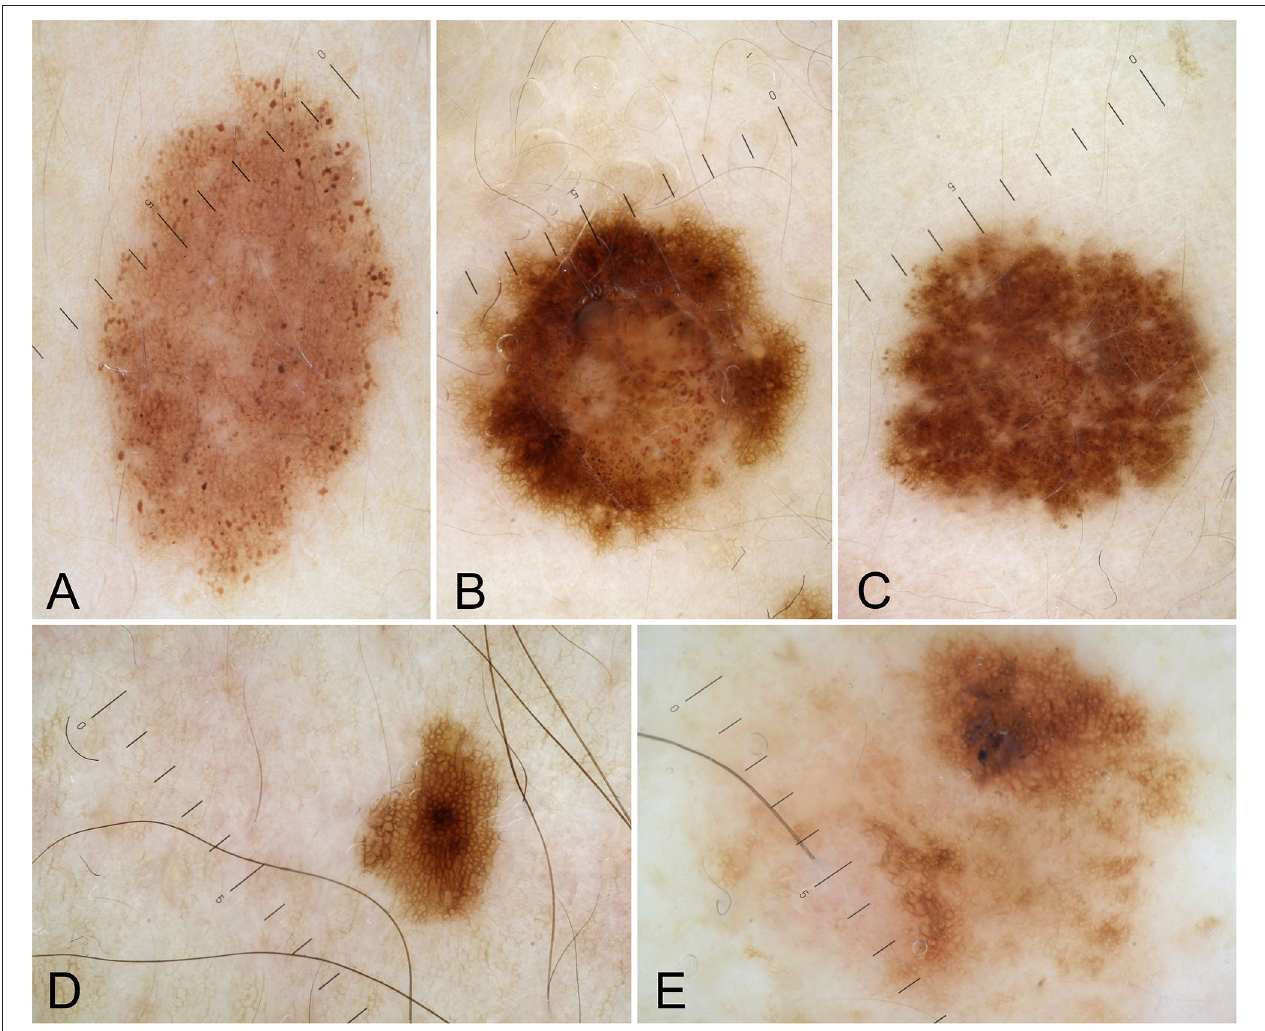
FIGURE 1 | Dermoscopic patterns of nevi: uniform globular pattern (A) ; mixed pattern composed of a central globular or structureless area surrounded by a network (B) ; mixed pattern composed of a central network or structureless brown-gray area surrounded by a peripheral rim of small brown globules (C) ; reticular pattern (D) ; unspecified pattern (E)